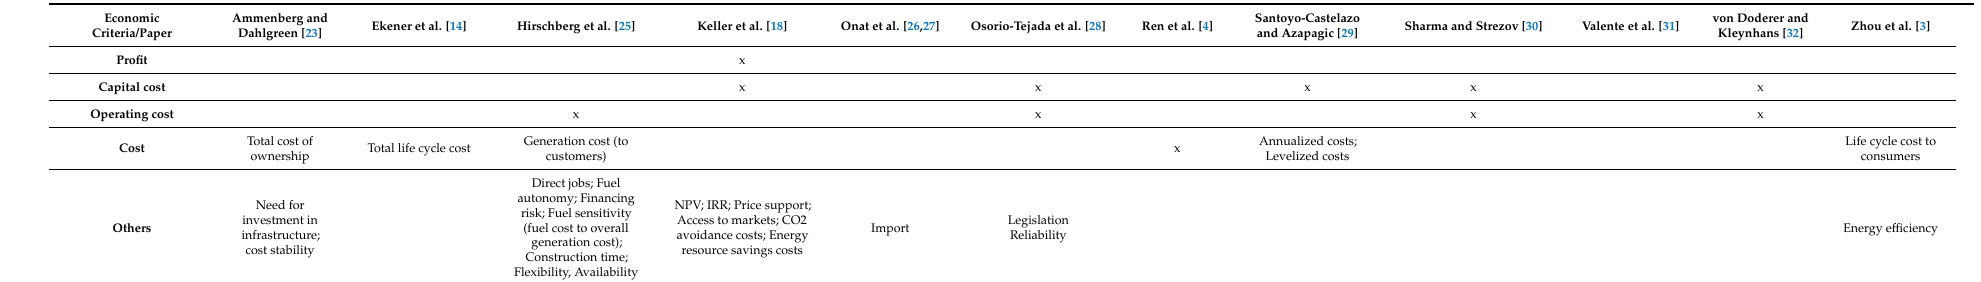
Table A2. Economic criteria used in LCSA-related